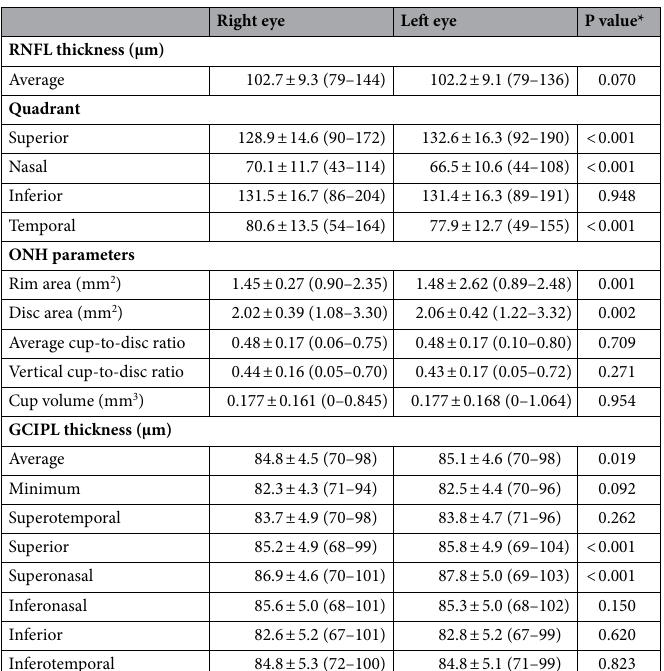
Table 1. Interocular differences (right eye–left eye) in optical coherence tomography parameters between the right and left eyes (n = 310). Data are presented as mean ± standard deviation (range). RNFL retinal nerve fiber layer, ONH optic nerve head, GCIPL ganglion cell-inner plexiform layer. *Paired t